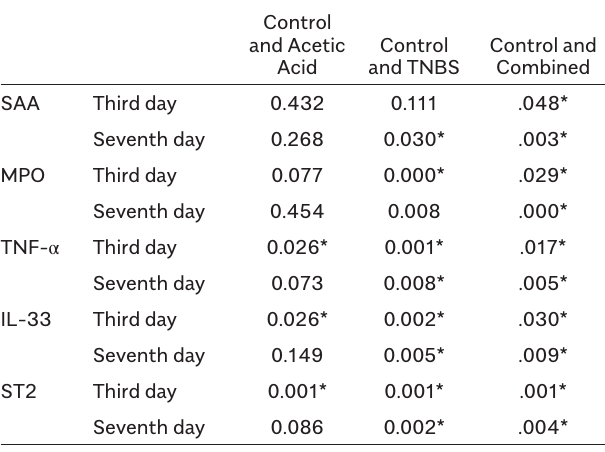
Table 3. Comparison of Study and Control Groups